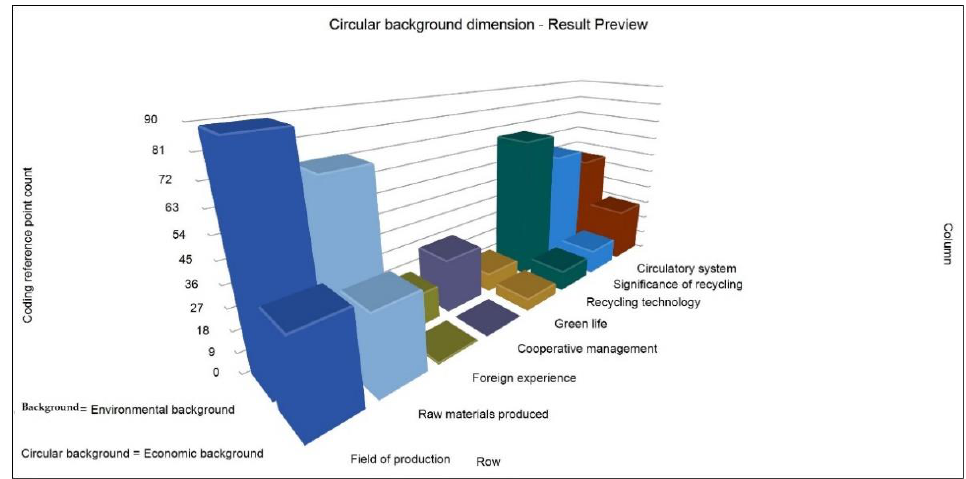
Figure 7. Reference point counting diagram of matrix coding under cyclic background dimension.